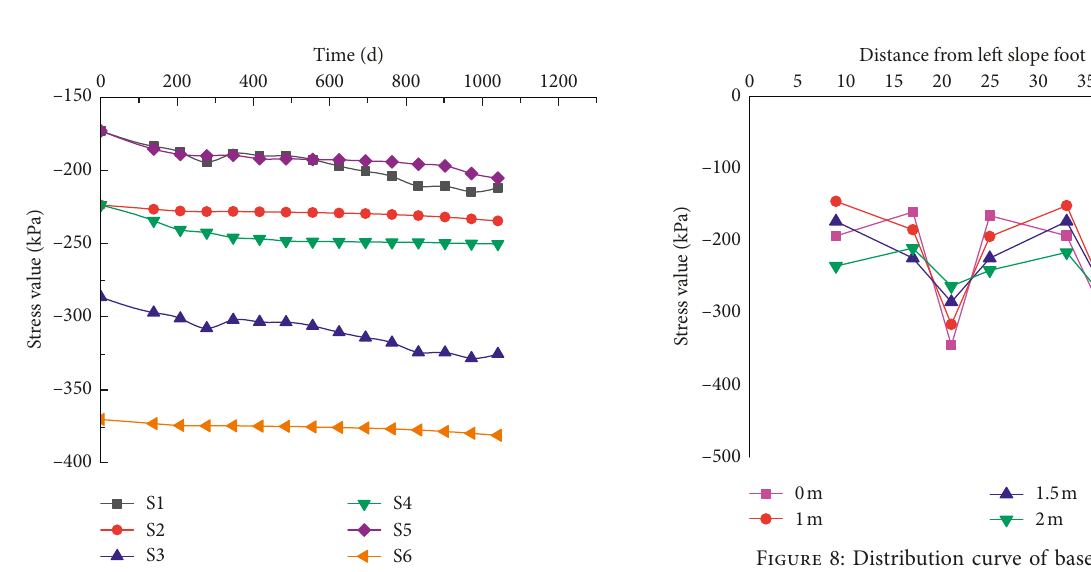
Figure 7: Stress-time distribution curve.